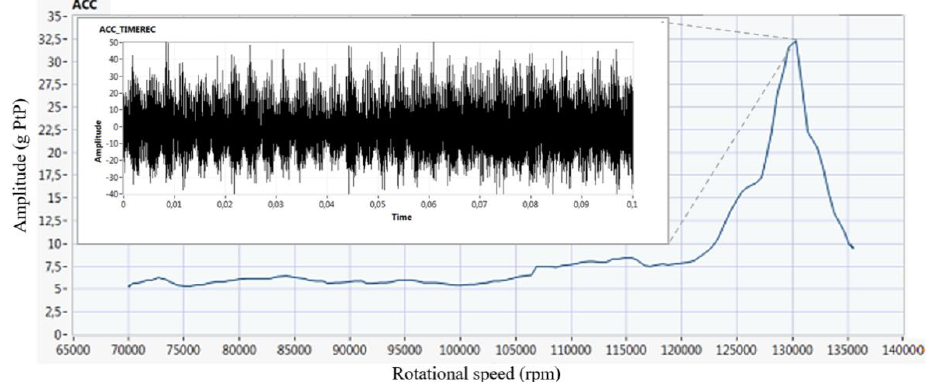
Figure 3. Vibration acceleration amplitude (g peak to peak) vs. rotational speed (rpm) and a time record of 0.1 s at the peak resonance.